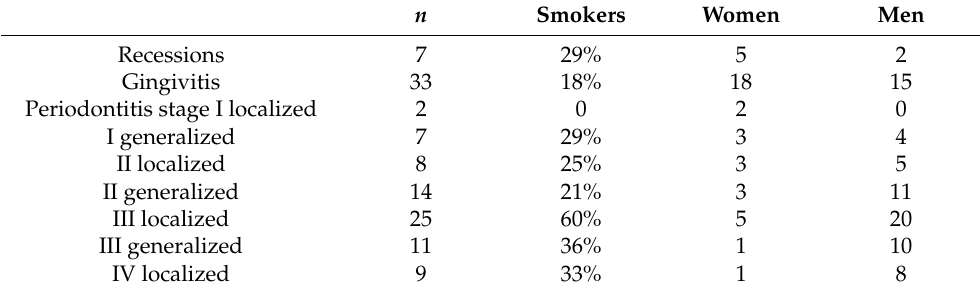
Table 1. Distribution of periodontitis stages including the risk factor of smoking in the patient population. n